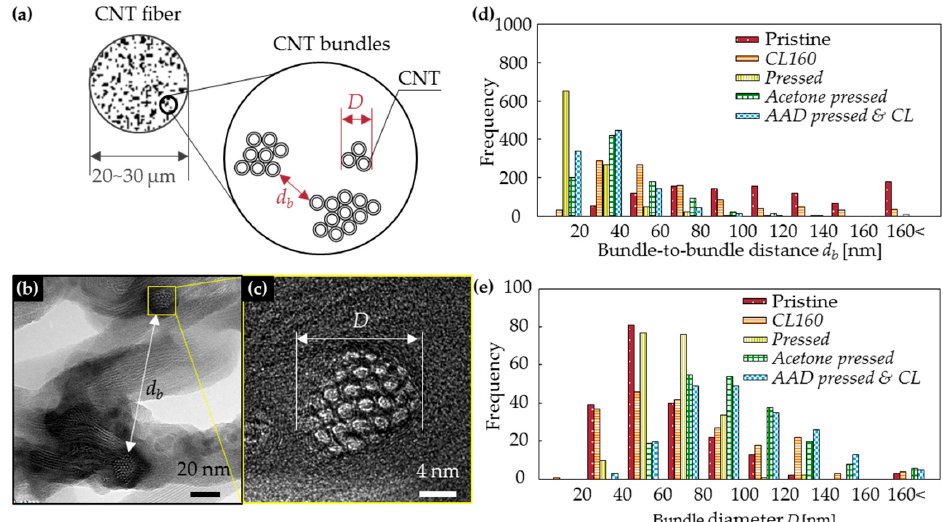
Figure 3. ( a ) The schematic diagram and ( b , c ) TEM images of the hierarchical structure of CNTF. The effects of pressing on the distribution of the structures of CNTF: ( d ) bundle-to-bundle distances d b of CNTF and ( e ) bundle diameters D .